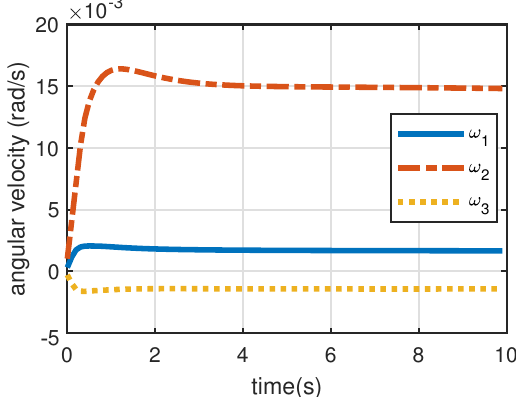
Figure 10. The time histories of angular